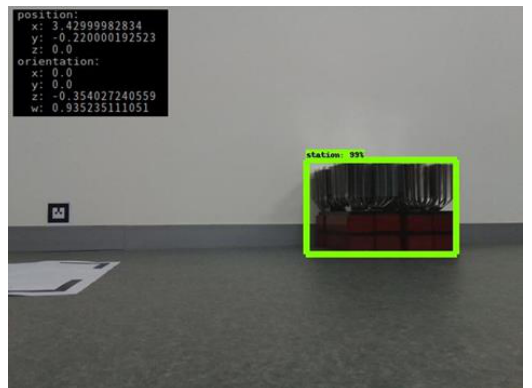
Figure 9. Energy node detection.